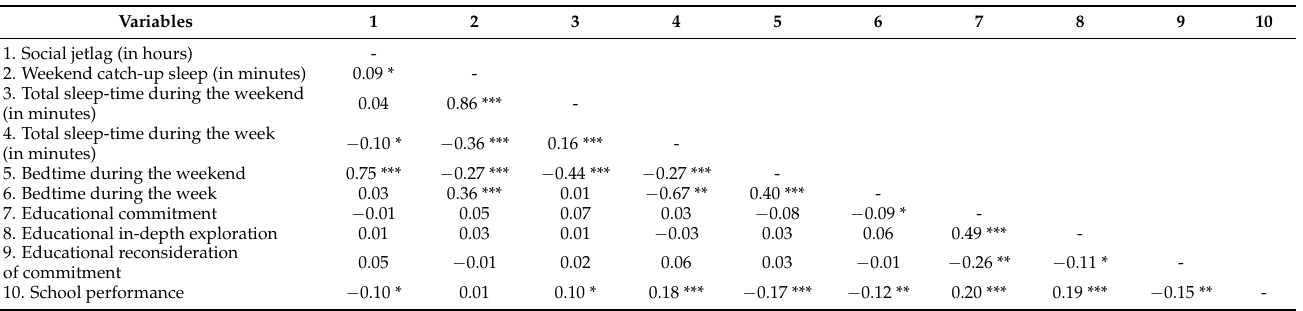
Table 2. Correlations between objective sleep-patterns and school-experience variables. Significant correlations are marked with